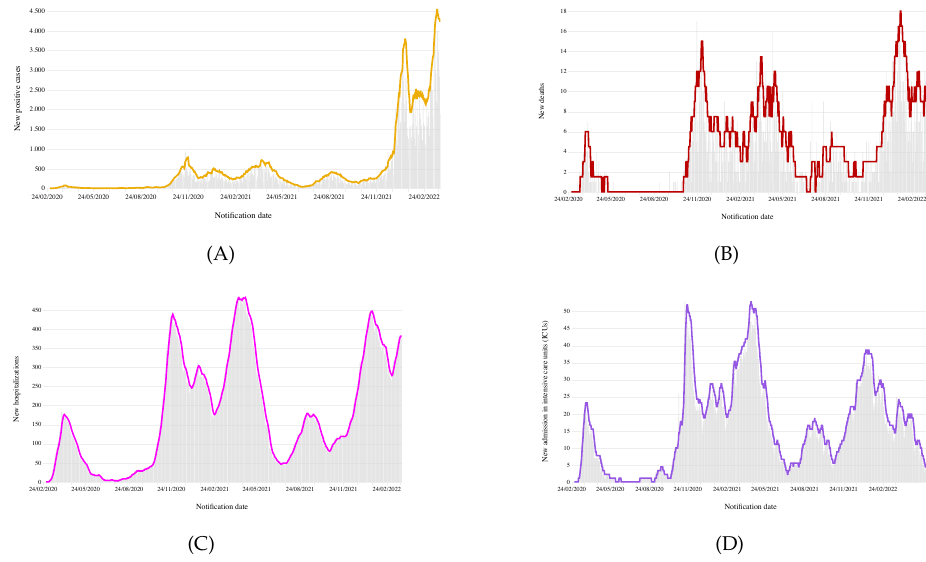
Figure 4. Calabria epidemiological data: ( A ) new positive cases; ( B ) total amount of deaths; ( C ) hos- pitalized patients with symptoms and ( D ) in intensive